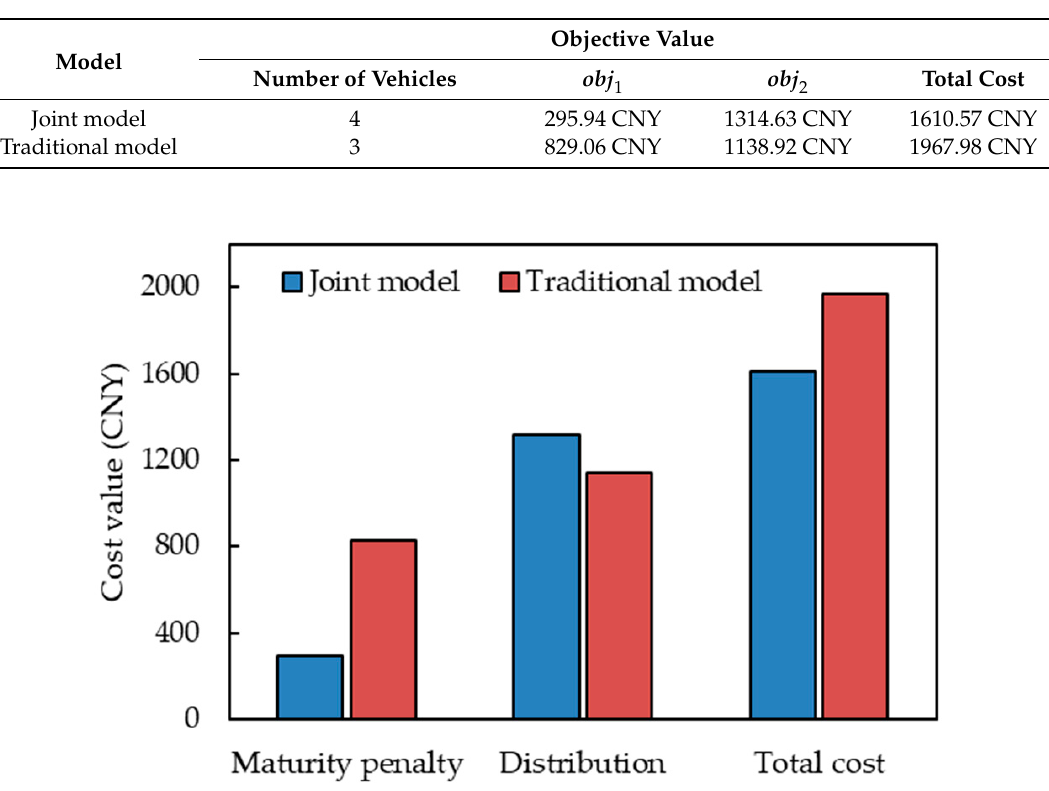
Table 6. Comparison results of the joint model and traditional model.